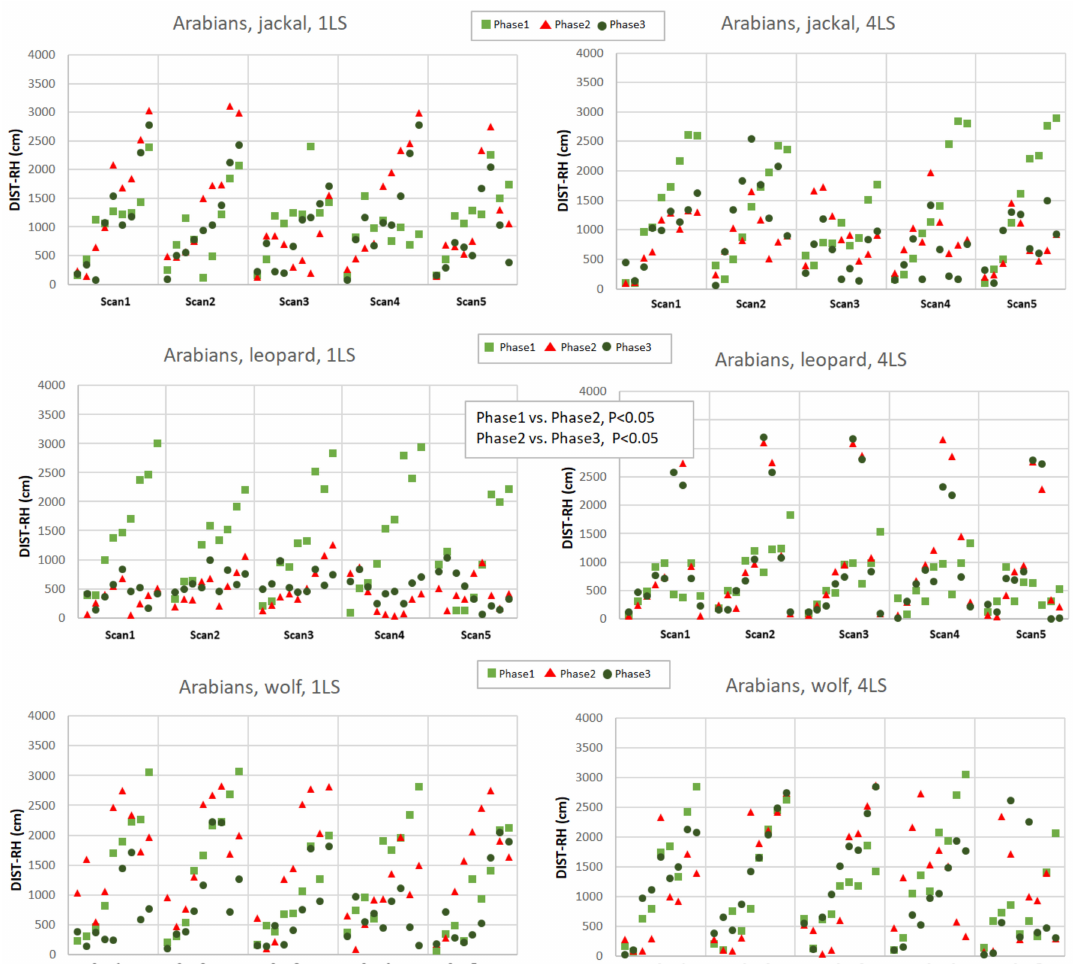
Figure A1. Distance to the reference horse (DIST-RH, cm) in Arabians in response to jackal’s, leopard’s and wolf’s vocalisation played from 1LS and 4LS in pre-, playback and post-playback phases. Each point represents the distance of individual horse from the RH. Phases are depicted with light green squares (phase 1, pre-playback), red triangles (phase 2, playback) and dark green circles (phase 3, post-playback). Only significant di ff erences between phases were shown in the